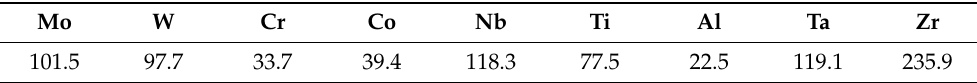
Table 4. β γ values of γ matrix elements of Ni-base alloys (MPa/at.% 1/2 ) [9,28].